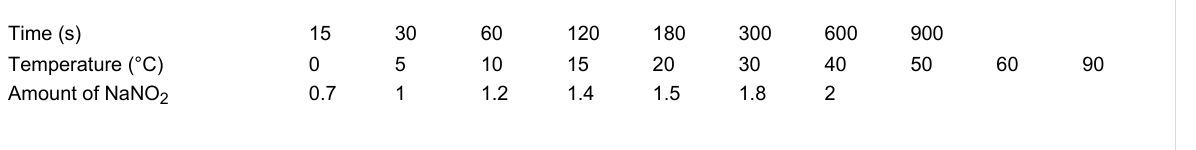
Table 1: Conditions of the univariate experiments using 30 s, 15 °C and 1.5 equiv NaNO 2 as standard.